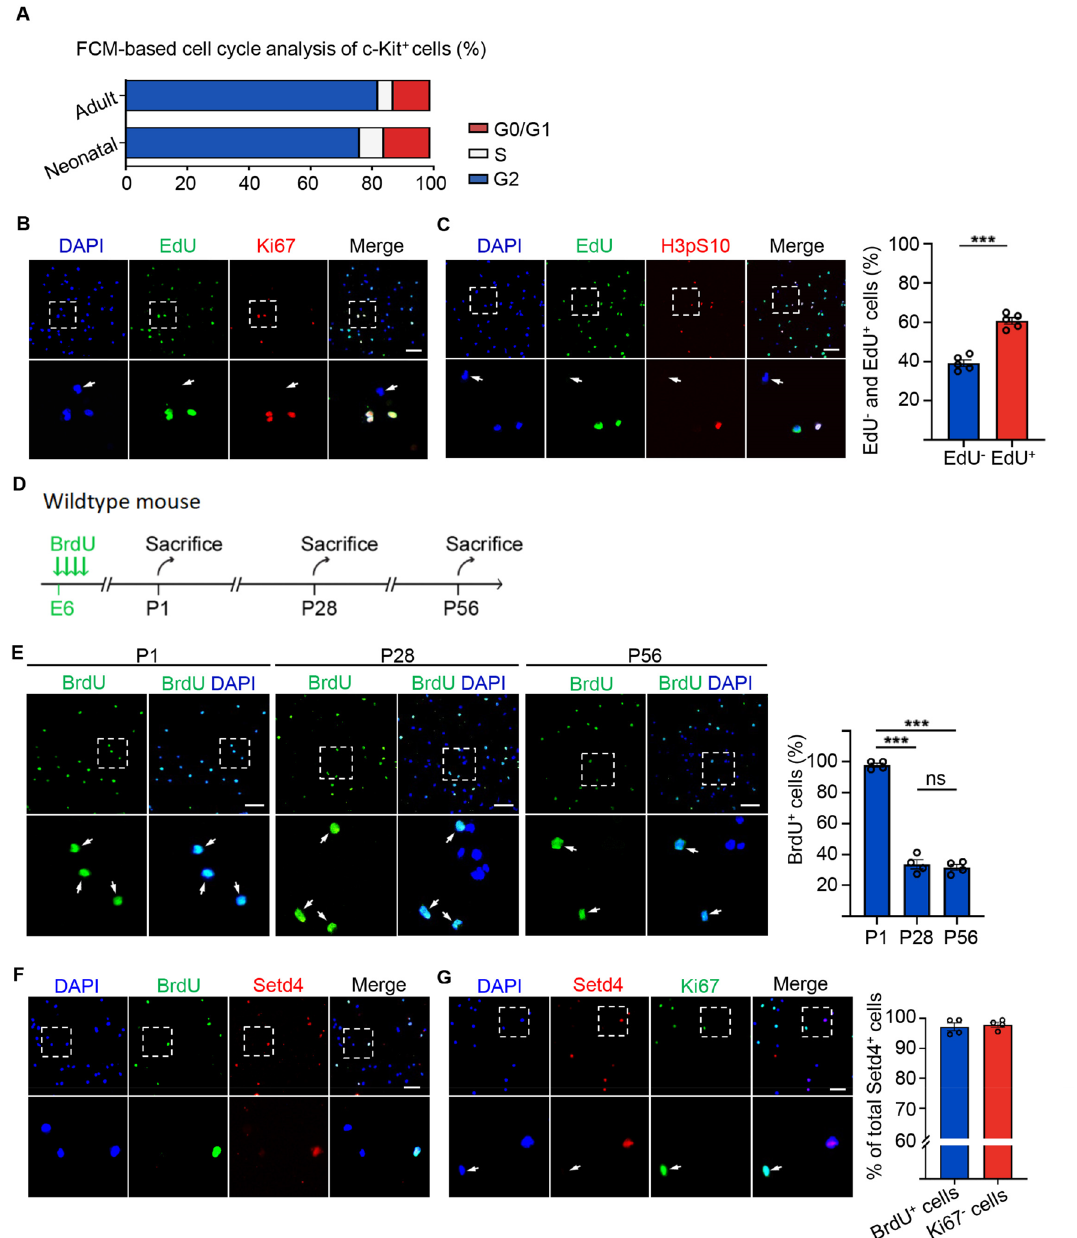
Figure 1. Identification of quiescent c-Kit + cells. ( A ) FMC cell-cycle analysis of FACS-sorted c-Kit + cells. ( B , C ) Representative immunofluorescence and quantification for c-Kit + cells with EdU incorporation and proliferation marker, Ki67, H3pS10. n = 5 mice. ( D ) Experimental outline for BrdU retention assay. ( E – G ) Representative immunofluorescence and quantification for c-Kit + cells with retained BrdU in P1, P28 and P56 hearts ( E ), Setd4 retained BrdU ( F ) and the cell proliferation marker, Ki67 in P56 hearts ( G ). n = 4 mice. Nuclei were stained with DAPI. Scale bars = 50 μm. All data are represented as mean ± SEM. Unpaired t test for ( B ) and ( F ), one-way ANOVA with Bonferroi’s correction for multiple comparisons test for ( E ). *** p < 0.001, ns not